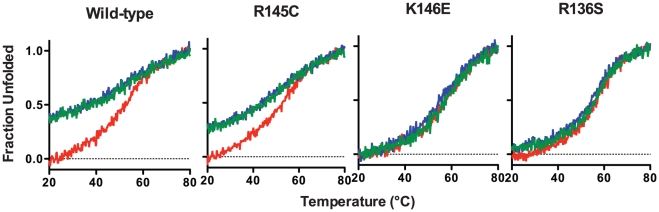
Reversibility of the thermal denaturation of WT apoE3 and variants.ApoE3 was thermally unfolded while following the CD signal at 222 nm (red trace). After reaching 80°C, the protein was gradually refolded by cooling the sample chamber down to 20°C (blue trace). The protein sample was then thermally unfolded again (green trace).